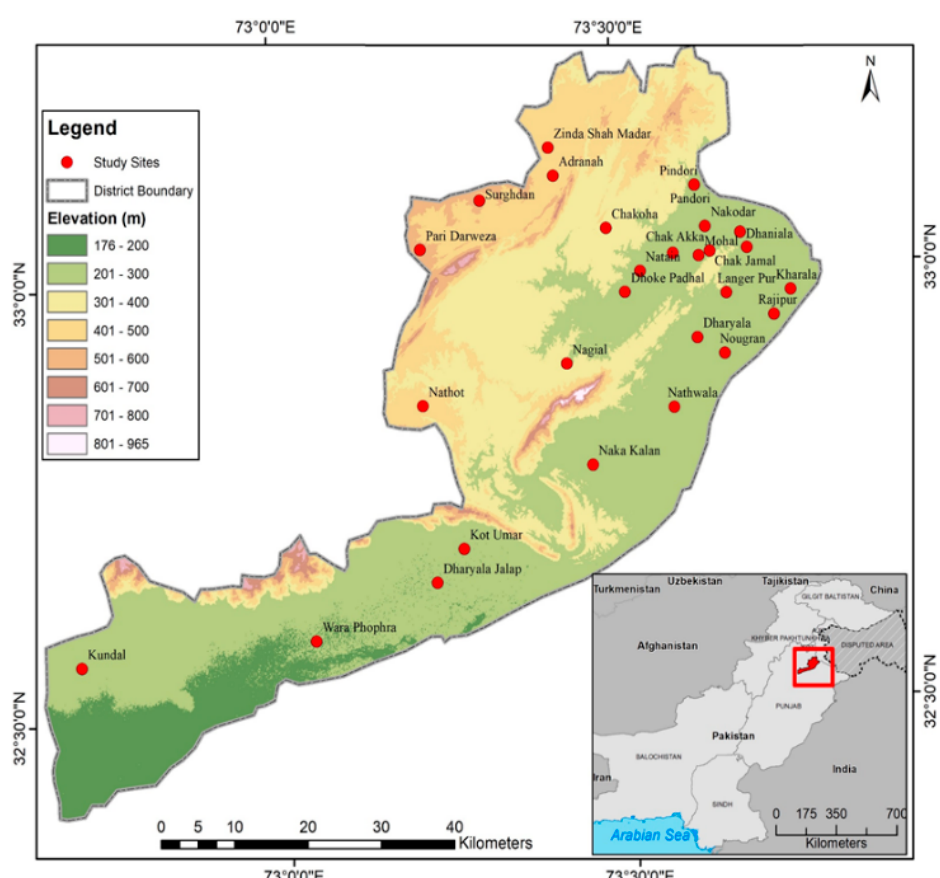
Figure 2. The map of the study area displaying the studied sites/village locations.